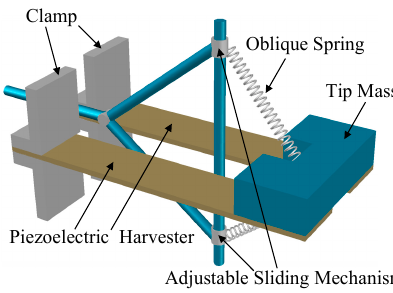
Figure 17. Schematic representation of the axial loads based MTT proposed in [34].